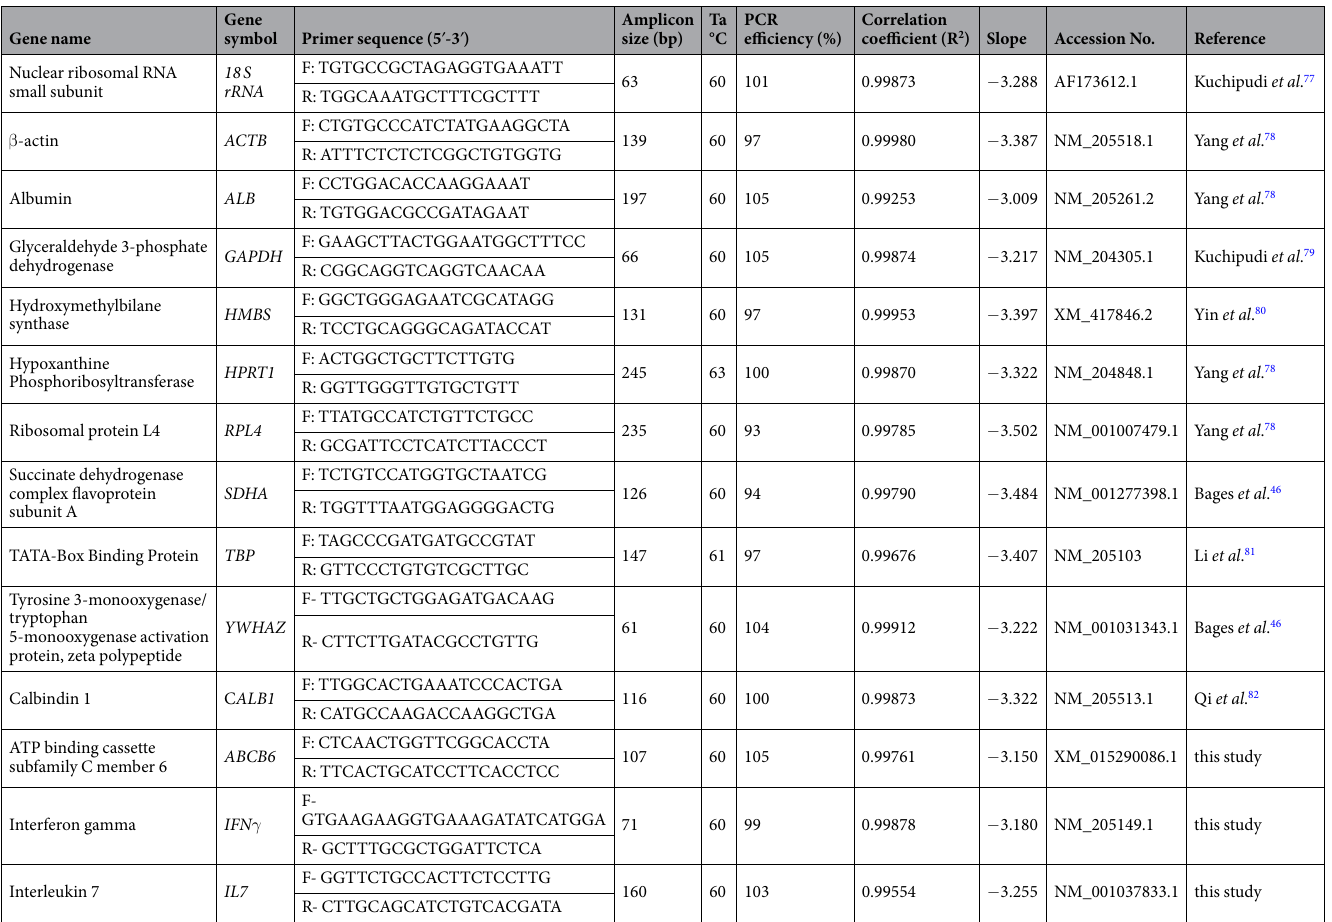
Table 3. Candidate reference and target genes in expression studies by qPCR in the shell gland and spleen of laying hens challenged with infectious bronchitis virus T and Vic S strains. For calculating amplification efficiency, a standard curve was generated using a 10-fold dilution of RNA amplified on the Rotor-Gene Q thermocycler real-time system. Standard curve was obtained by plotting the Cq values against the log of the starting quantity of template for each